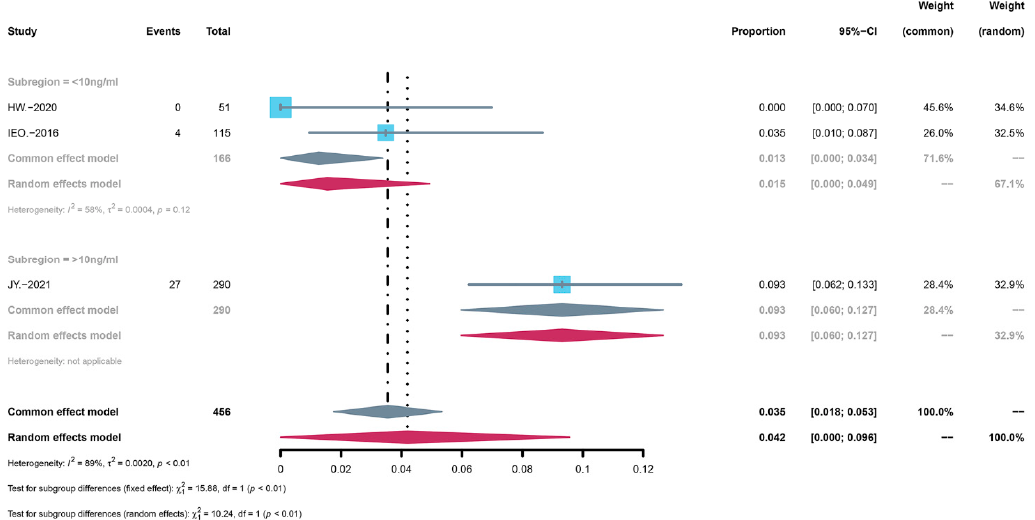
Figure 3. Forest map of serious adverse events after removal of the biased data.